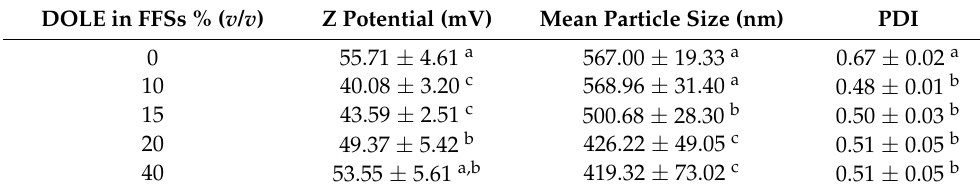
Table 2. Zeta potential, particle size, and PDI of FFSs containing DOLE (10–40% ( v / v )). The control was set up in the absence of DOLE.